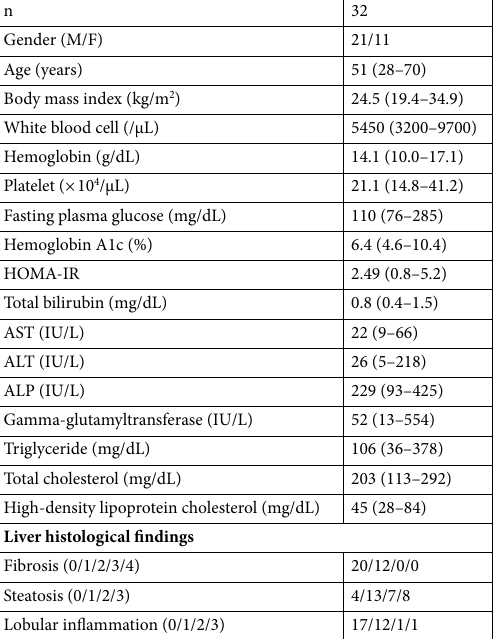
Table 1. Clinical characteristics of the study subjects. HOMA-IR Homeostasis Model Assessment of Insulin Resistance, AST aspartate aminotransferase, ALT alanine aminotransferase, ALP alkaline